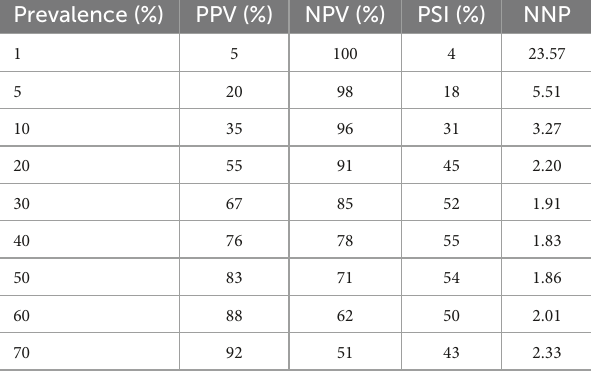
TABLE 3 Advanced performance metrics of the PO model at varying prevalence rates of PO